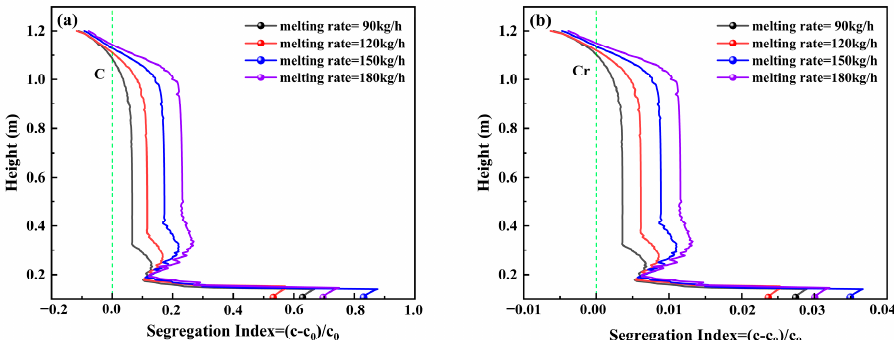
Figure 18. Distribution of Cr concentration at varying melting rate: ( a ) 90 kg/h, ( b ) 120 kg/h, ( c ) 150 kg/h and ( d ) 180 kg/h.